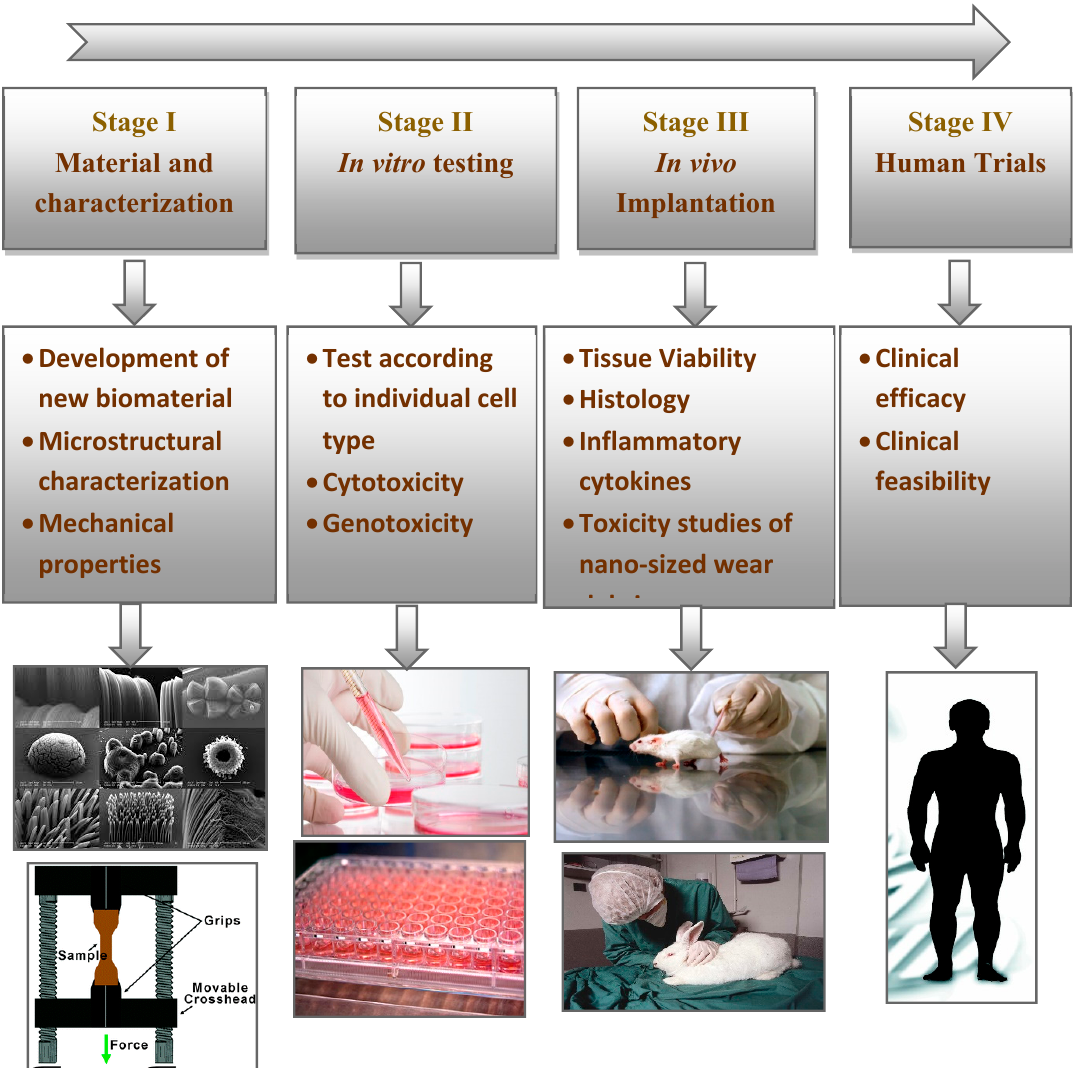
Figure 4. Steps involved in the translation of newly developed biomaterials.